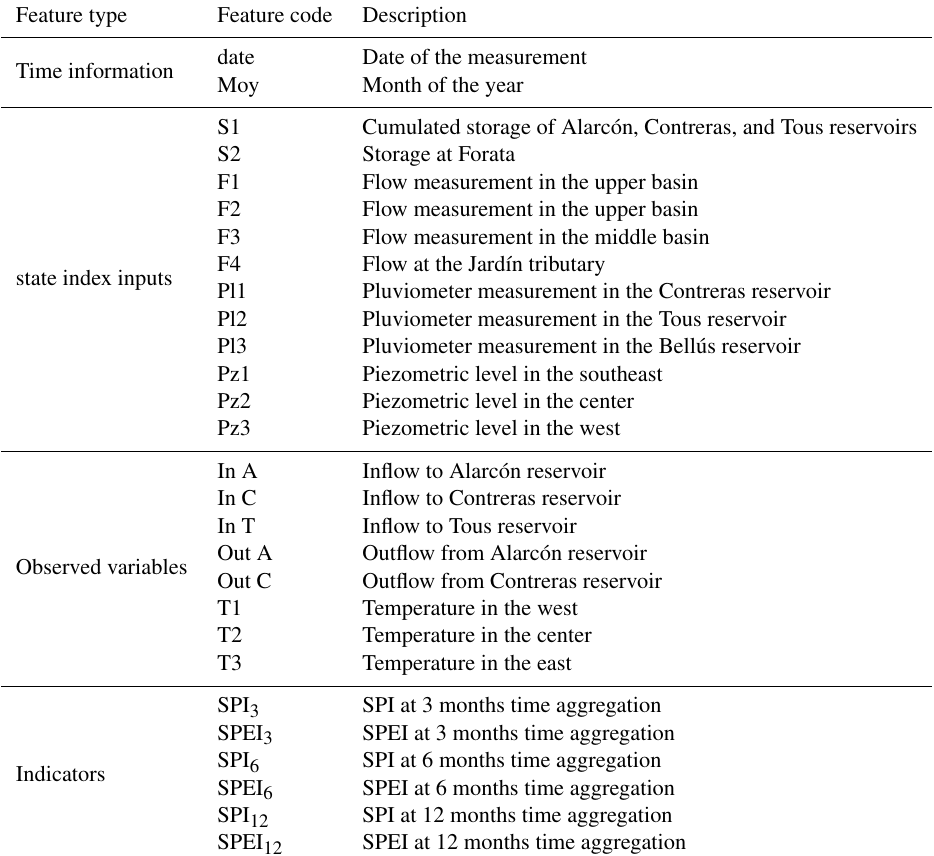
Table 1. Set of candidate input features for the feature extraction step via